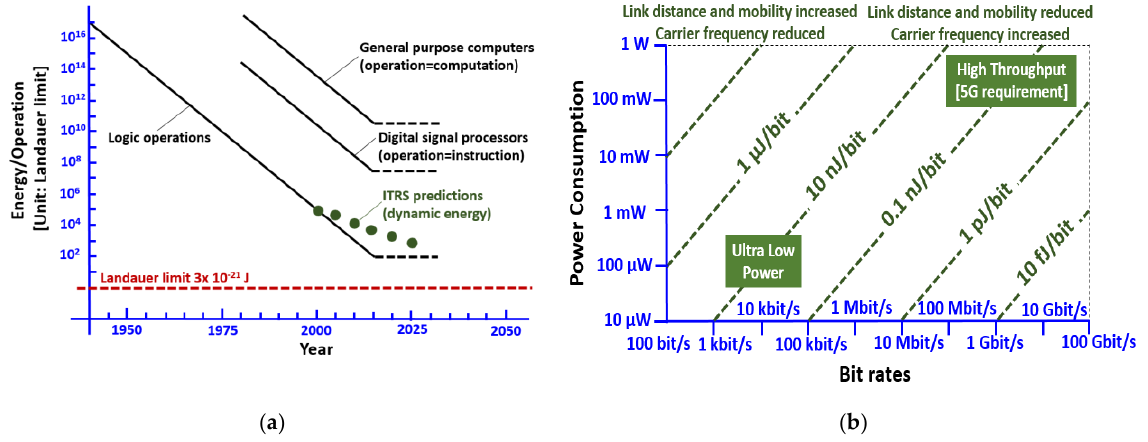
Figure 11. Technology trend ( a ) of dissipated energy per operation expressed in reference to Landauer limit against evolution over years showing saturation effects, power consumption versus bit rate ( b ).